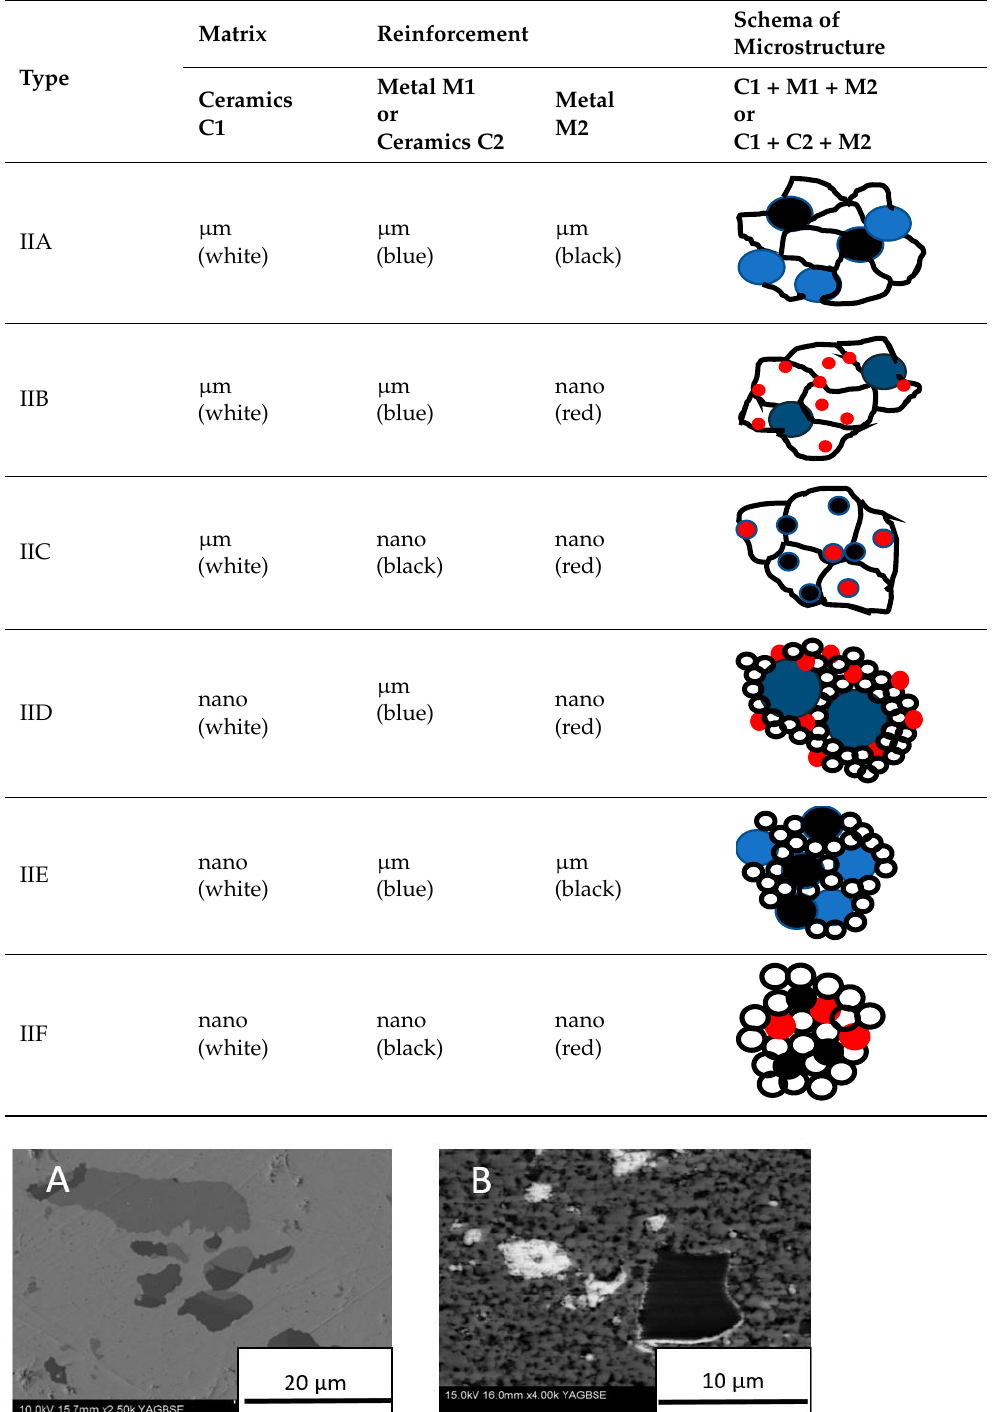
Table 2. Types of microstructures of ceramic–metal composites fabricated by consolidation of pow- ders: one ceramic and two metals with various variants of ceramics and metal powder size, or two ceramics and one metal with various variants of ceramics and metal powder size and their geometrical schemas.